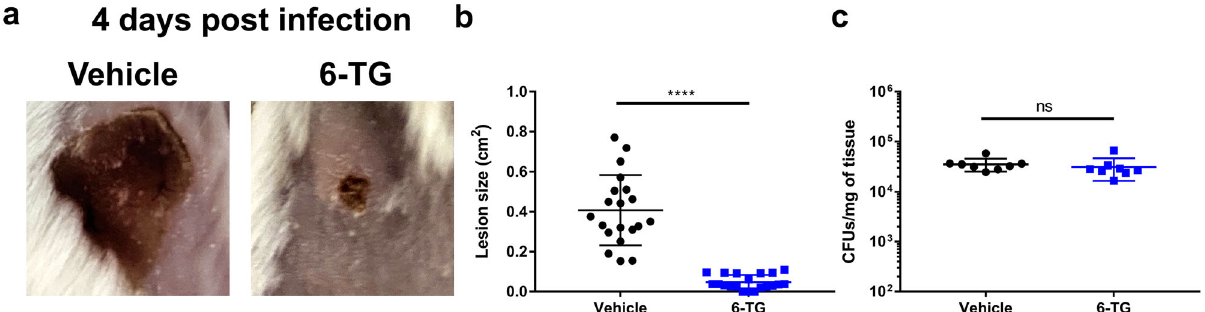
Fig. 5 Prophylactic treatment with 6-TG reduces necrotic lesion size in subcutaneous infection. a Representative images showing necrotic skin lesions 4 days post infection with S. aureus ± prophylactic 6-TG treatment. b Quantitation of necrotic skin lesion size 4 days post infection with S. aureus ± prophylactic 6-TG (20 µ g) treatment. Results are pooled from two independent experiments with 8 – 12 lesions per group ( n = 4 and 6 animals, respectively). Data are shown as mean ± SD (**** p ≤ 0.0001. Two-sided unpaired t -test). c Skin tissue was excised from mice infected with S. aureus 4 days post infection ± prophylactic 6-TG treatment (20 µ g) and plated onto TSA to enumerate CFUs. Results are from one experiment with 8 – 12 lesions per group ( n = 4 and 6 animals, respectively). Data are shown as mean ± SD (two-sided unpaired t